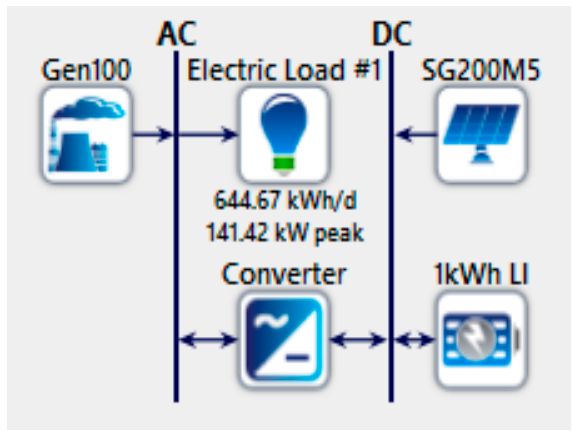
Figure 5. Proposed microgrid for the MUST site.